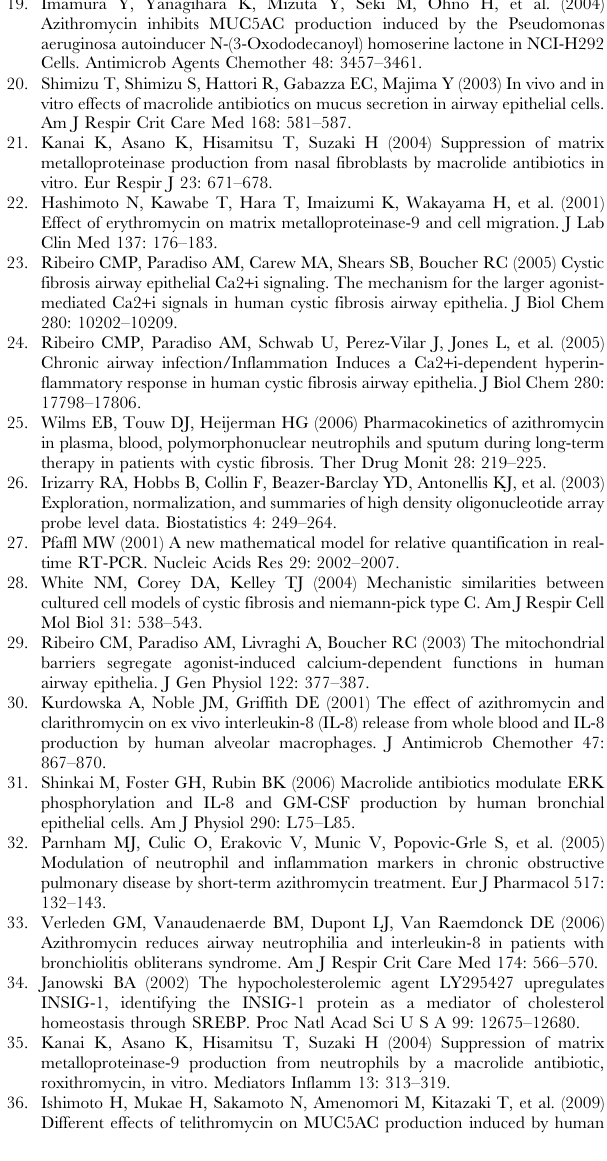
Found at: doi:10.1371/journal.pone.0005806.s007 (0.53